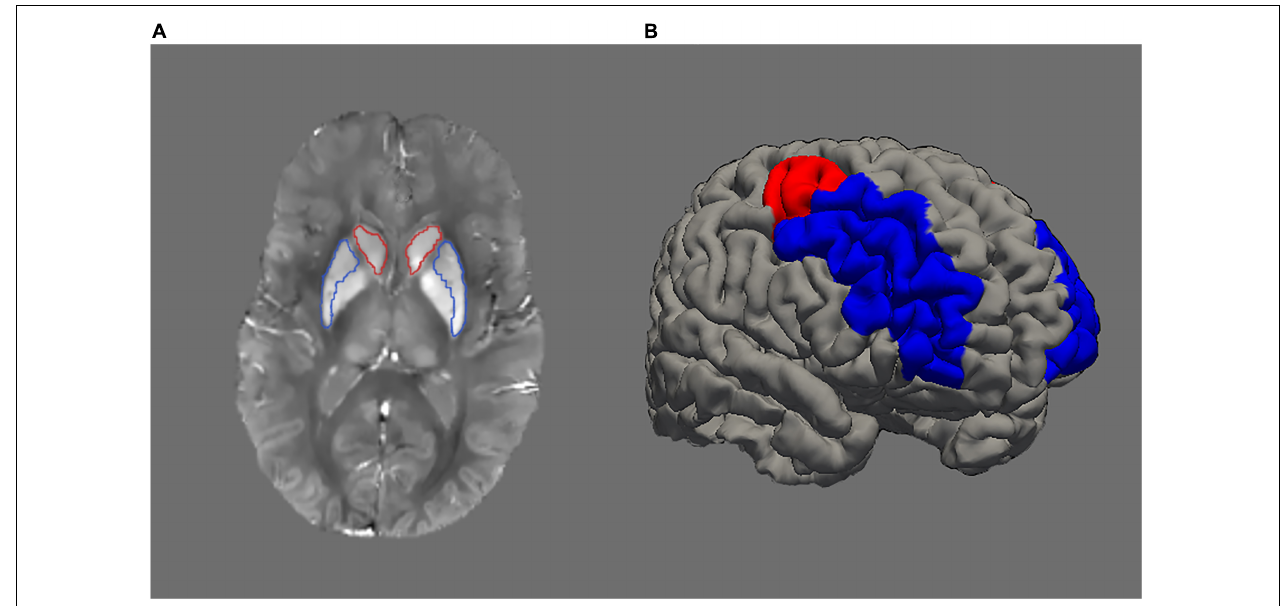
FIGURE 1 | (A) Example of a QSM (quantitative susceptibility mapping) image. Higher signal intensity denotes higher iron load. Striatum is represented by caudate (red outline) and putamen (blue outline). (B) Image illustrating dorsolateral prefrontal cortex with rostral middle-frontal cortex in blue colour and caudal middle-frontal cortex in red